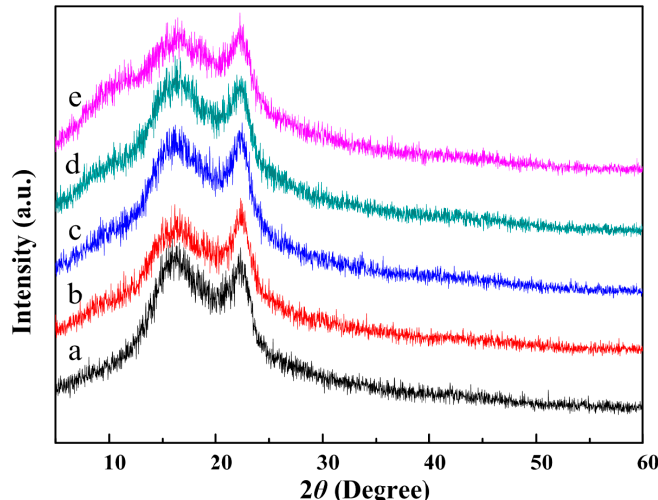
Figure 2. FTIR spectra of the CA/PVP hybrid nanofibers with varying PVP quantities ( a ) 0%; ( b ) 0.5%; ( c ) 1%; ( d ) 2%; ( e ) 5%. *: the position of corresponding characteristic peaks.